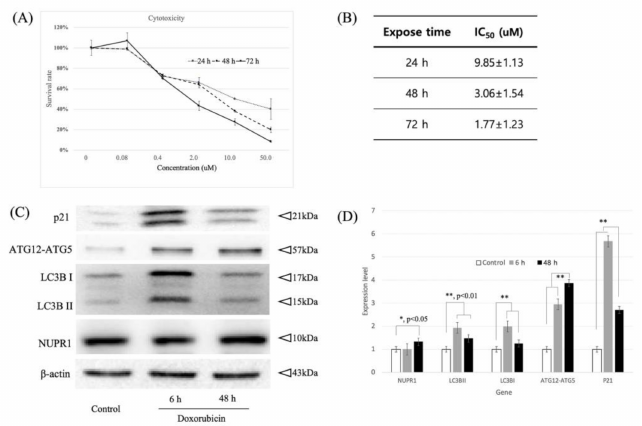
Figure 1. Effect of doxorubicin exposure time on cytotoxicity and NUPR1-related protein expression in MDA-MB-231 breast cancer cells. ( A ) Increasing concentrations of doxorubicin were assayed in MDA-MB-231 cells using a time-dependent approach. ( B ) Table indicating the IC 50 values of doxorubicin, calculated for MDA-MB-231 breast cancer cells. Cells were seeded in 48-well plates and incubated with increasing concentrations of doxorubicin. Values represent mean ± SD of at least three individual experiments. MDA-MB-231 breast cancer cells were treated with 1 µ M of doxorubicin for 6 and 48 h. Immunoblot images ( C ) and quantification ( D ) for NUPR1, p21, and autophagy-related protein (ATG12-ATG5, LC3B1, and LC3BII) levels as assessed by Western blot. β -Actin was used as loading control. *, p < 0.05; **, p < 0.01; bars, SD.